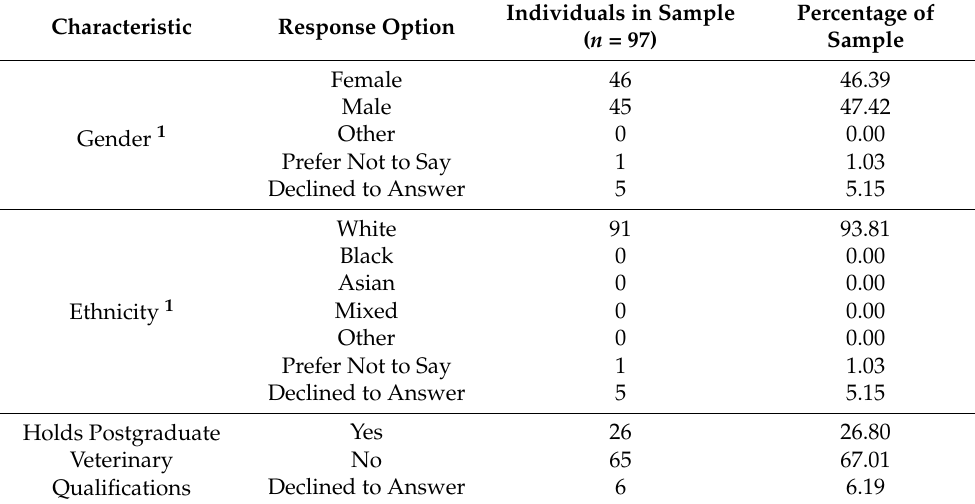
Table 1. Demographic Details for All Vignette